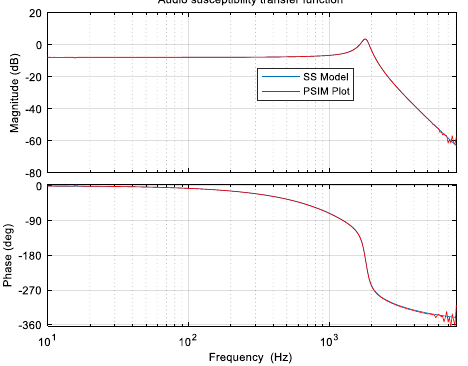
Figure 17. Audio − susceptibility transfer function for a buck converter with an input filter.